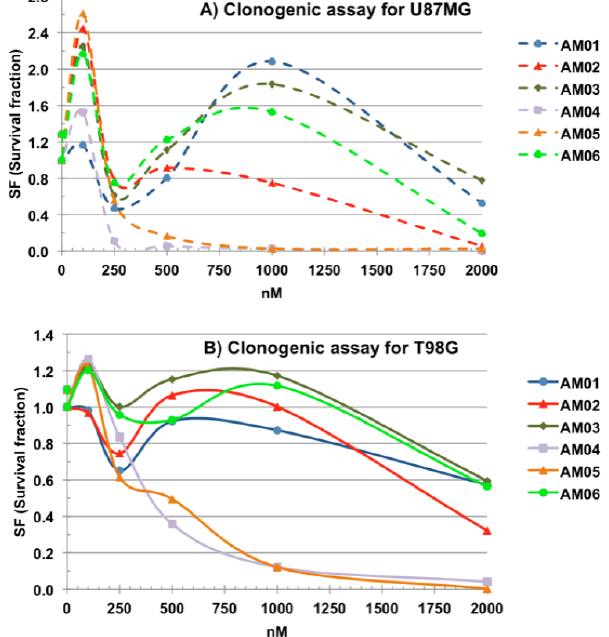
Figure 2. Clonogenic assay for sesquiterpene lactone compounds. ( A ) Clonogenic assay for U87MG. ( B ) Clonogenic assay for T98G. n = 3, mean of SF.